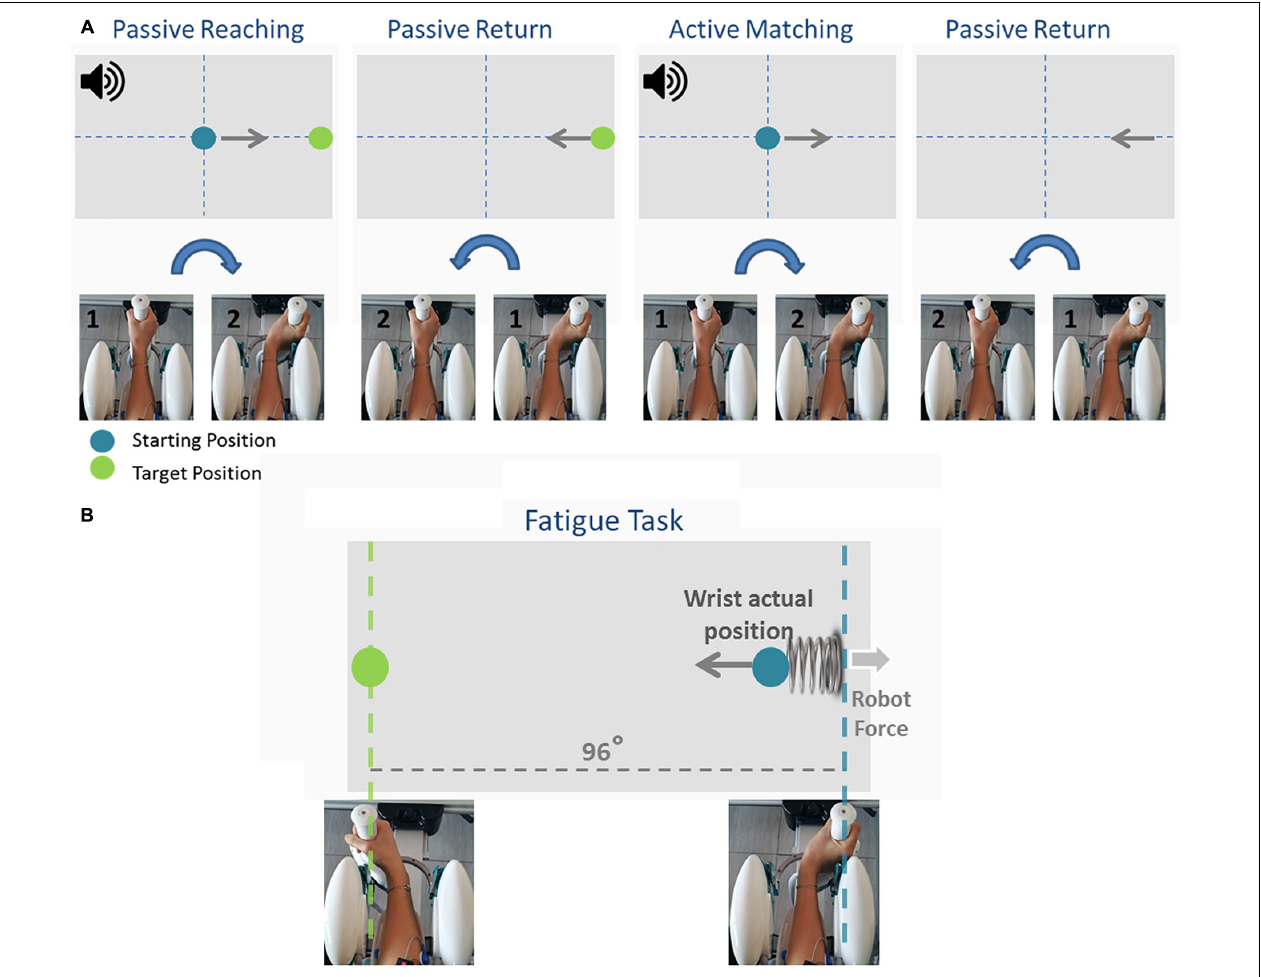
FIGURE 2 | The temporal sequence of the Joint Position Matching task and the Fatigue task. During the Joint Position Matching task (A) , the robot moved the participant’s hand to a target location, held it there for 3 s, then brought the hand back to the start position. The participant then moved the robot handle to the remembered target position. During the fatigue task (B) , participants performed alternating flexion/extension movements, and the robotic device applied a viscoelastic force field that provided assistive forces to wrist extension movements and resistive forces during wrist flexion